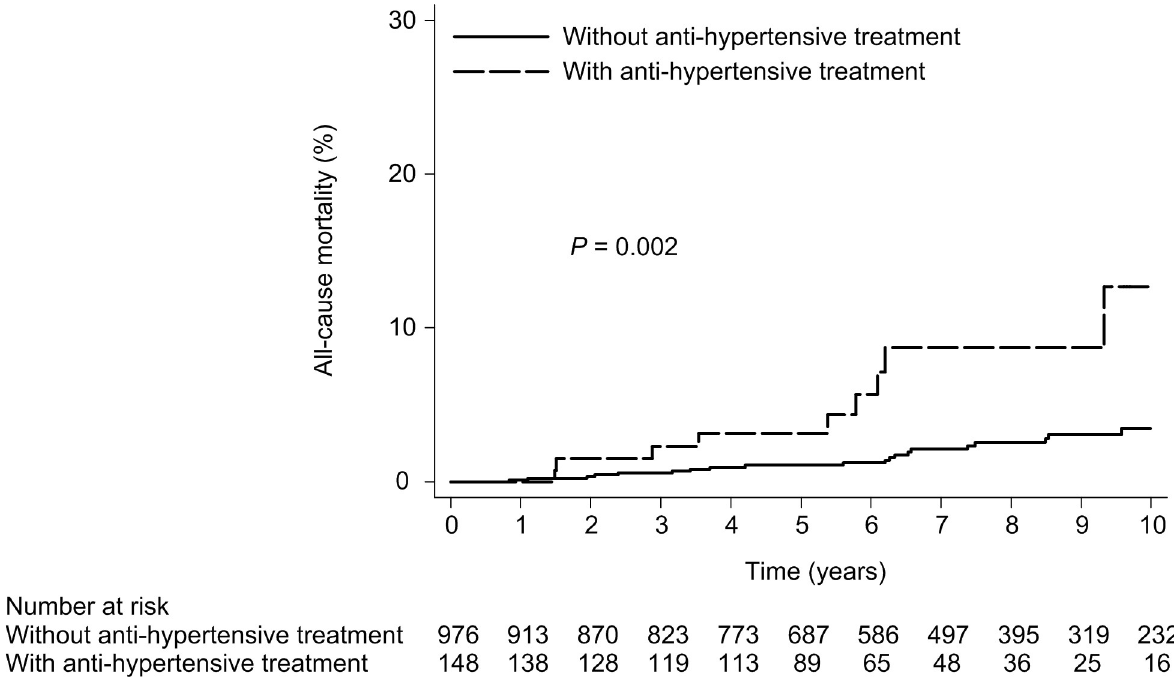
Fig 8. All-cause mortality according to anti-hypertensive treatment in all patients with SVR. (10- year mortality rate, with vs. without anti- hypertensive treatment: 12.68% vs. 3.46%, HR = 3.42, 95% CI = 1.58–7.44, P = 0.002).